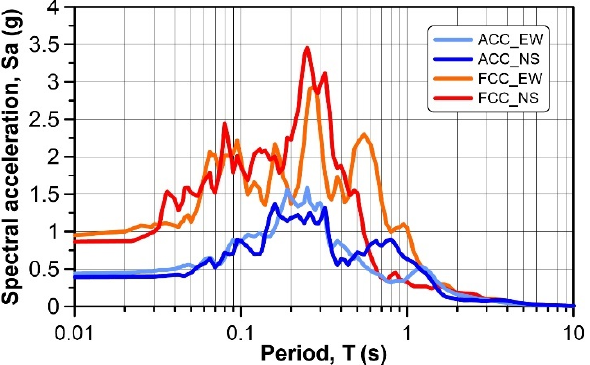
Figure 19. Acceleration response spectra (5% damping) vs. the period for the selected input